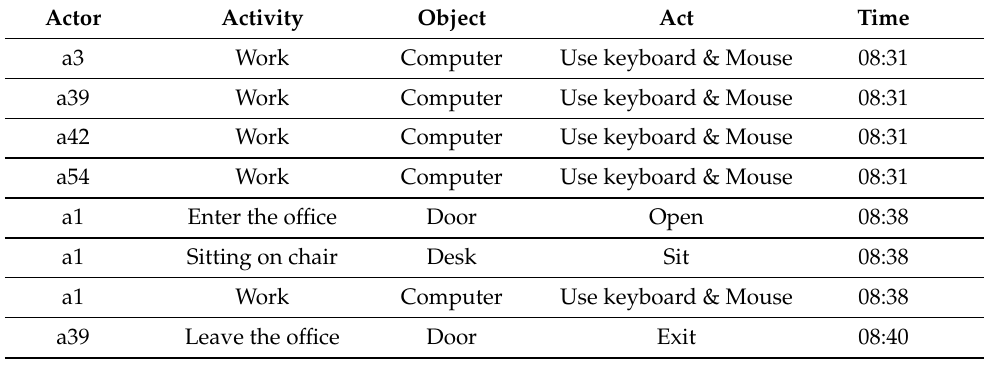
Table 1. Sample observational records.